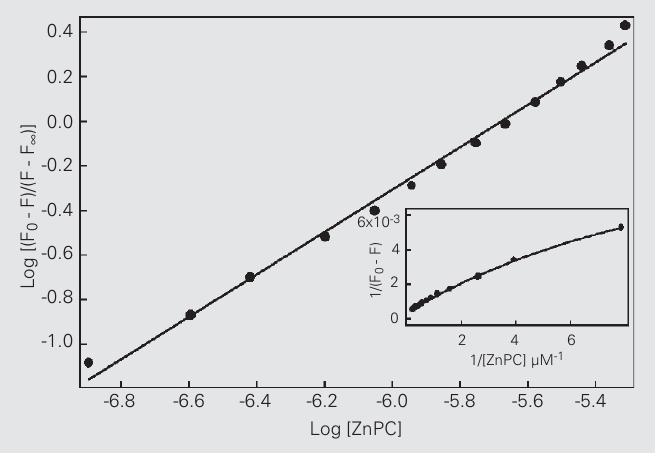
Figure 4. Double log plot of the quenching of protein fluorescence by zinc phthalocyanine in organic medium. Inset , Double reciprocal plot in organic medium (F = measured fluorescence of a solution containing the protein and the phthalocyanine, F 0 is the fluorescence of a solution of protein alone, F ∞ is the fluorescence intensity of BSA saturated with ZnPC, and [PC] is the ZnPC